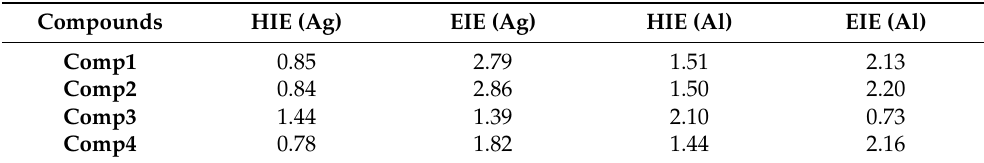
Table 2. The electron/hole injection energy (EIE/HIE) barriers in eV from benzothiazoles to silver (Ag)/aluminum (Al) electrodes calculated at the B3LYP/6-31+G** level. Compounds HIE (Ag) EIE (Ag) HIE (Al) EIE (Al) Comp1 0.85 2.79 Comp2 0.84